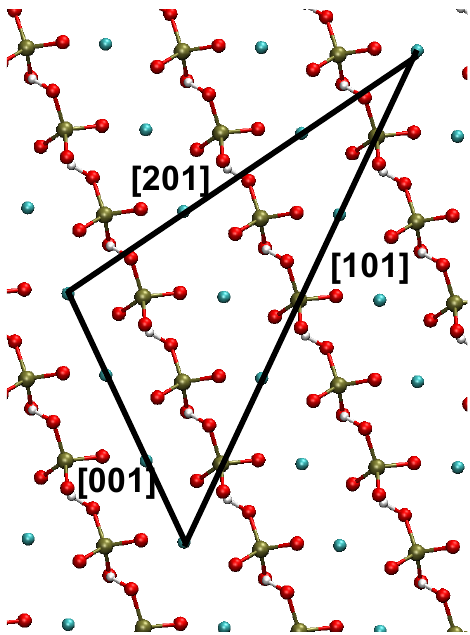
Figure 1. One of the two Brushite {010} surfaces viewed from above with crystallographic directions indicated with solid black lines. Water is omitted for clarity. H is white, O is red, P is tan, and Ca is